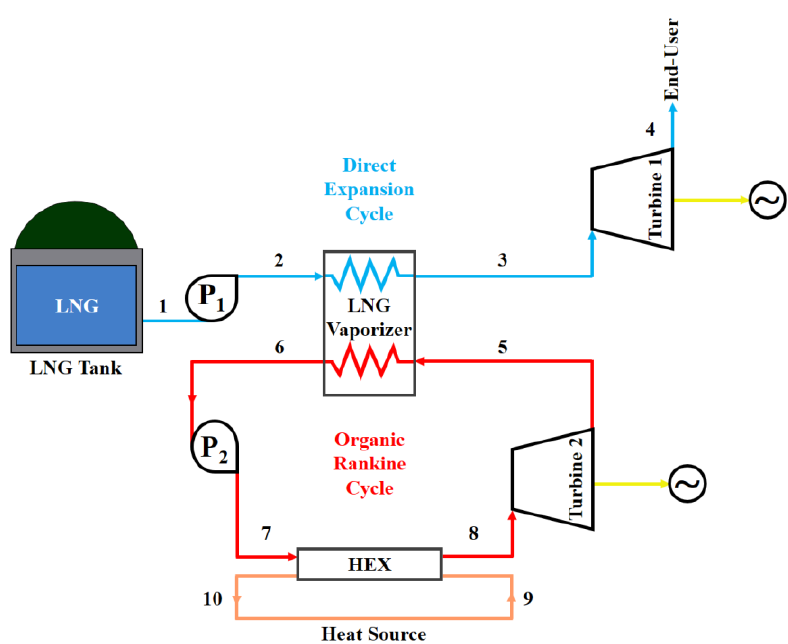
Figure 2. Schematic illustration of organic Rankine and direct expansion cycle in LNG cold energy power generation.